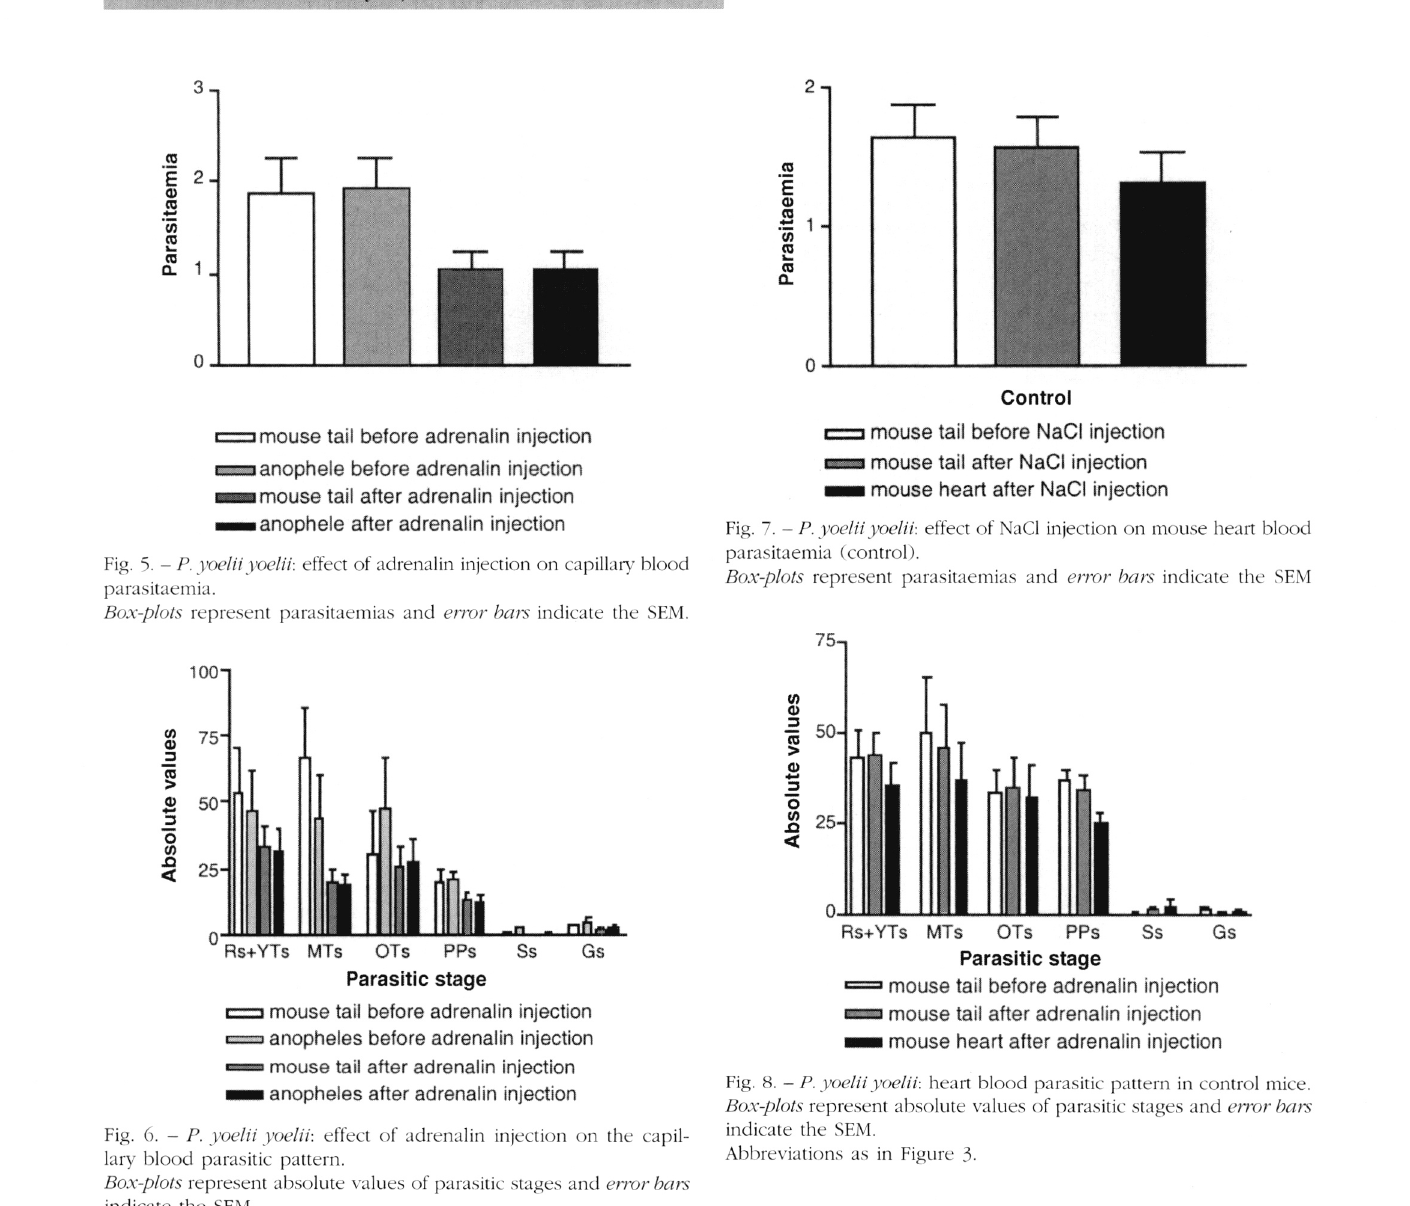
Fig. 6. - P. yoelii yoelii : effect of adrenalin injection on the capil­ lary blood parasitic pattern. Box-plots represent absolute values of parasitic stages and error bars indicate the SEM Abbreviations as in Figure 3.